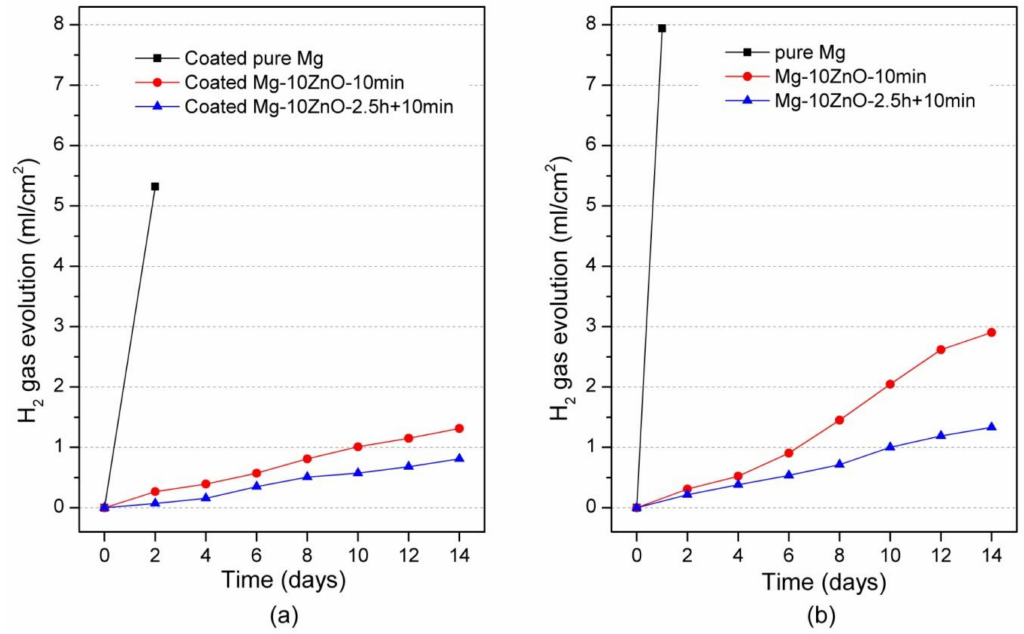
Figure 7. Hydrogen gas evolution during the immersion test, ( a ) the result of HAp coated samples in this study, and ( b ) the result of uncoated samples was cited from